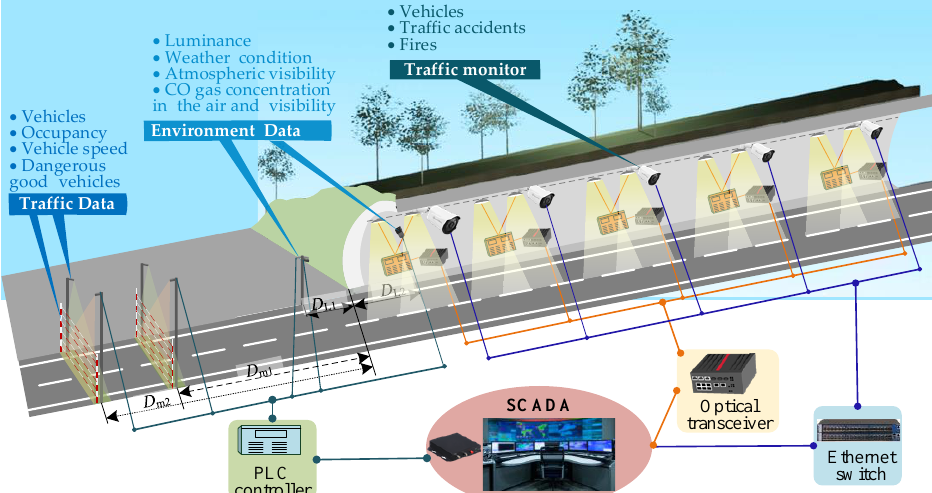
Figure 6. Schematic of the hardware of the SCADA tunnel lighting